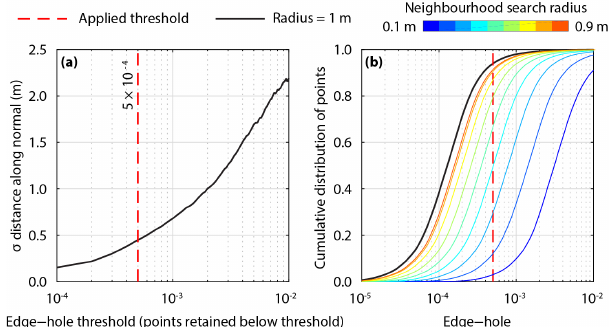
Figure 9. Sensitivity analysis for the edge–hole filter. (a) A change detection is undertaken between two point clouds where no observ- able movement occurred. The standard deviation for a single point cloud therefore indicates the level of noise between the two. When high EH values are retained, the standard deviation of change in- creases. (b) Cumulative proportion of EH values within an entire point cloud. Each line represents a different neighbourhood radius search, with a 1m radius selected to ensure a minimum of four points, the minimum needed to estimate the CoG, would be found. An inflection in the number of points retained is used to define the threshold at 95%, ensuring that artefacts such as holes are not in- troduced into the point cloud by over-removal of points. While the EH values change with the neighbourhood search radius, their dis- tribution across the point cloud remains the same due to the normal- isation by point